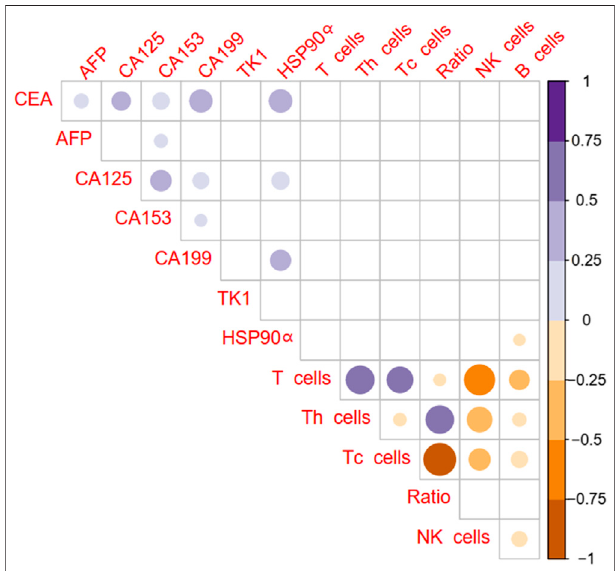
FIGURE 2 | Correlation of plasma HSP90 α protein levels with routine tumor markers and immune cells in colorectal cancer patients (Pearson analysis). Blue color represents a positive correlation, brown color represents a negative correlation, and the shade of color represents the degree of correlation. The results with p < 0.05 were fi lled with color and display in the diagram.